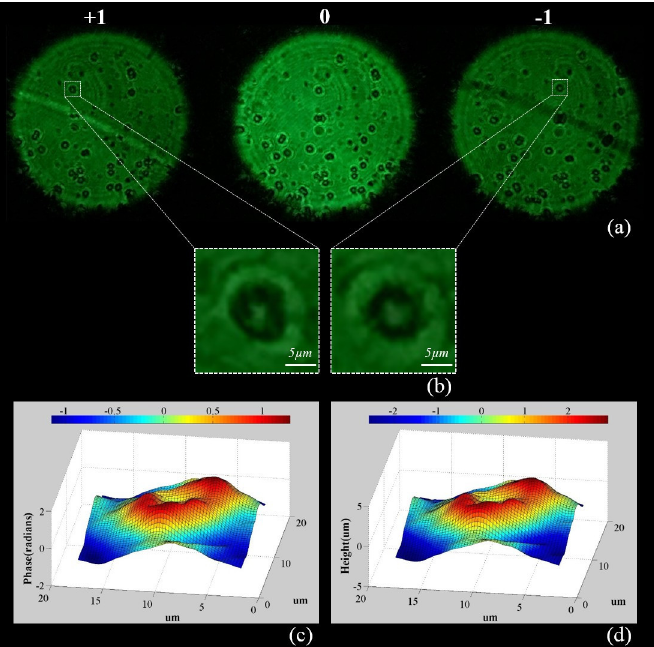
Fig 6. Exemplary results of using the smartphone-based wavefront sensor for red blood cell imaging. (a) A raw photo taken by the smartphone camera, consisting of 3 images of the pupil; (b) Pre-selected and cut images for the wavefront computing algorithm; (c) Calculated phase map; (d) Reconstructed height